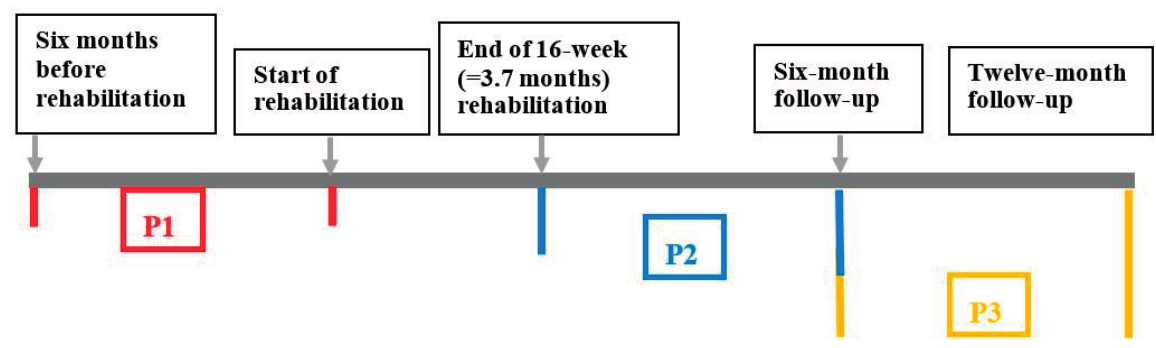
Figure 4. The time frames for the measuring periods concerning health care utilization